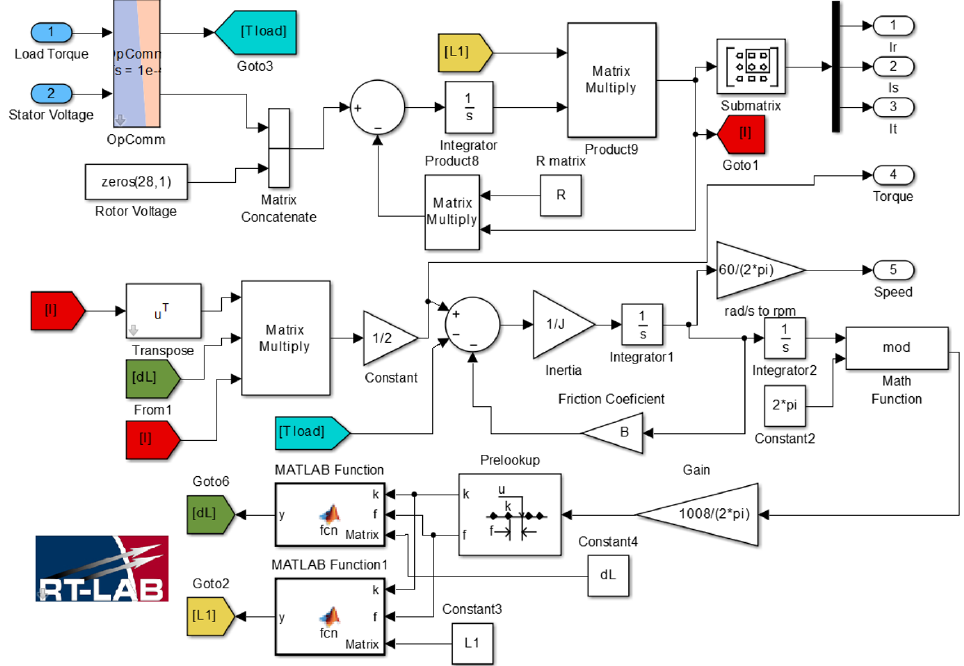
Figure 1. Analytical model of the induction machine using Equations (10)–(12) in Matlab/Simulink. The characteristics of the machine are found in Table